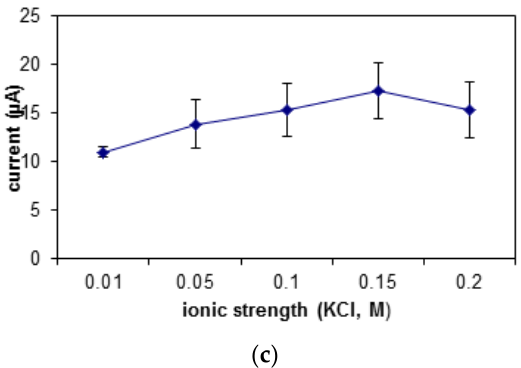
Figure 7. The effect of different ( a ) pH, ( b ) concentrations of PBS, and ( c ) KCl salt ionic strengths on the biosensor’s response.